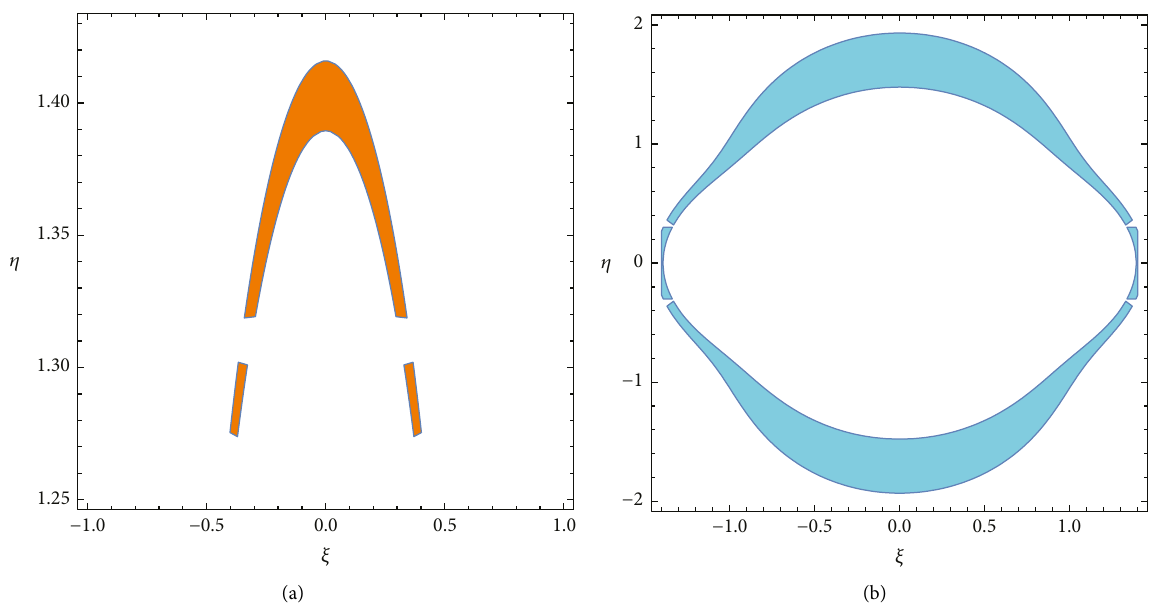
Figure 12: Condition (i): projection of stability regions (a) b � 0 . 67 and a � 0 . 78; (b) b � 0 . 80 and a � 0 .